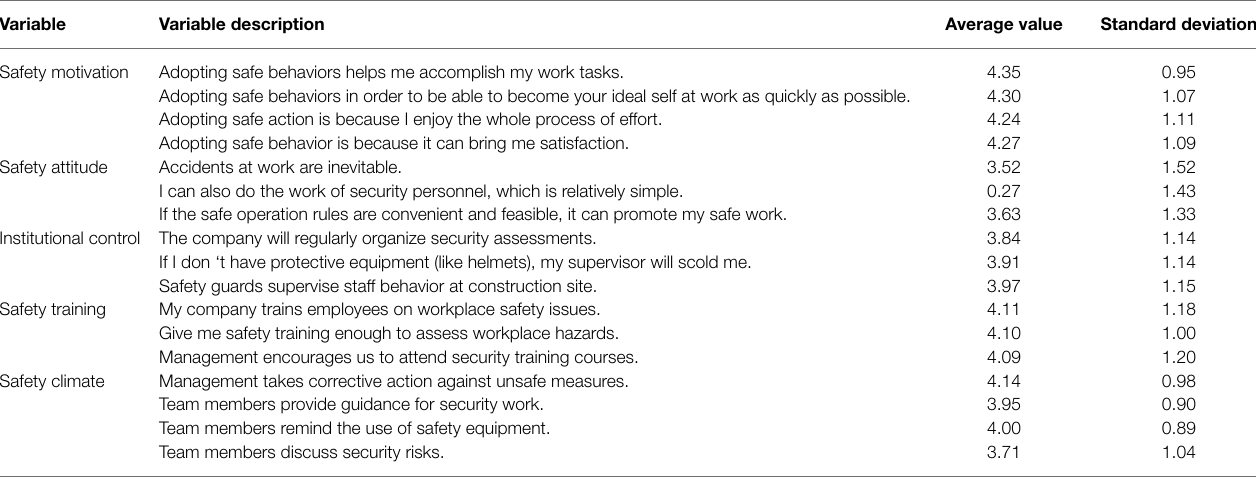
TABLE 2 | Variable measurement and descriptive statistics. Variable Variable description Average value Standard